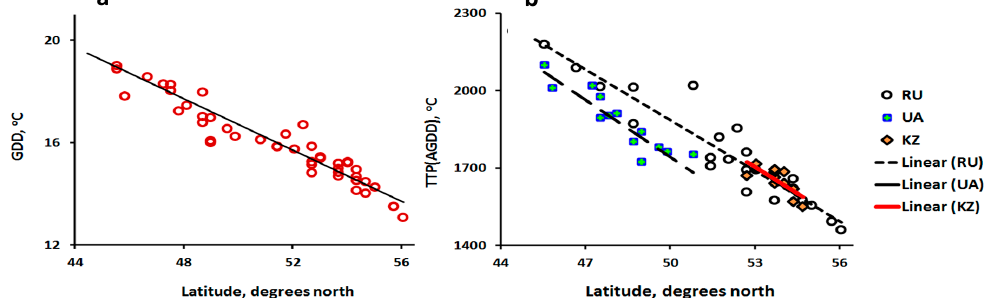
Figure 6. Thermal climates as a function of latitude revealed by: ( a ) average daily GDD; and ( b ) Thermal Time to Peak (TTP GDD ). Latitudes were the geographic centers of AMSR-E pixels. All 49 study sites are displayed in both figures. In ( b ), hollow circles = Russia, orange diamonds = Kazakhstan, and cyan crosses on blue background = Ukraine. Both panels show a general decrease in ( a ) GDD or ( b ) TTP as latitude increases from 44° to 56°N. The uppermost two hollow circles are the northernmost study sites (site 49, Kazan’, Russia and site 48, Cheboksary, Russia), while the lowermost two hollow circles are the southernmost study sites (site 1, Cherkessk, Russia and 2, Stavropol, Russia).